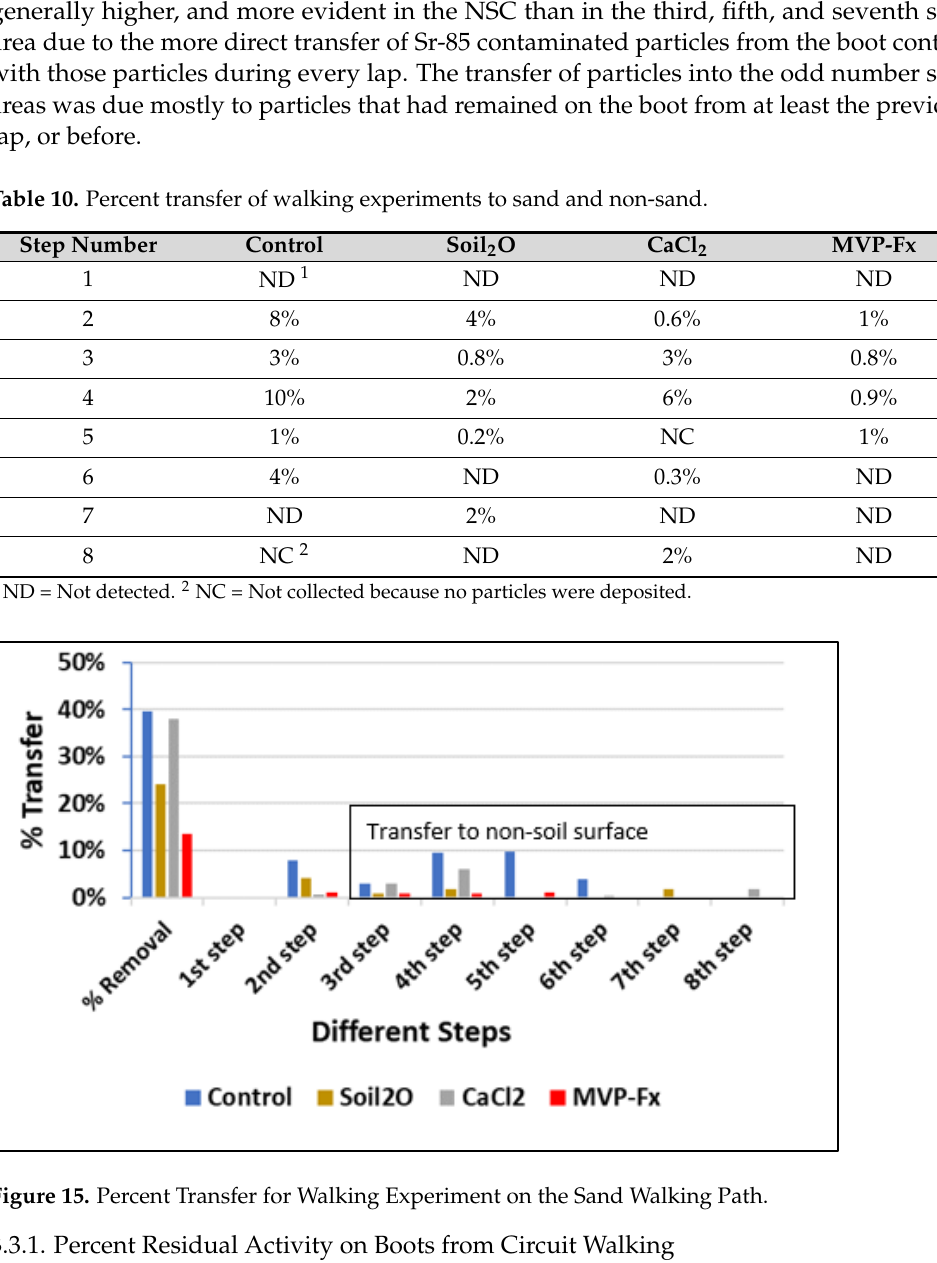
Figure 16. Percent Residual of Sr-85 Contaminated Particles from Foot Traffic Experiments.